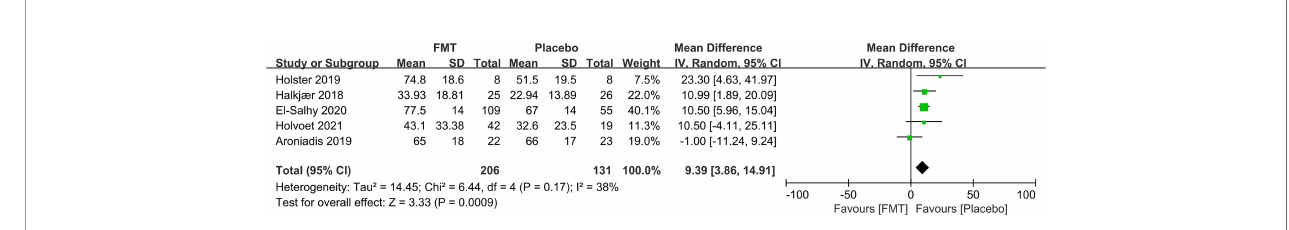
FIGURE 3 | Forest plot of RCTs of quality of life in comparison between FMT and placebo in irritable bowel